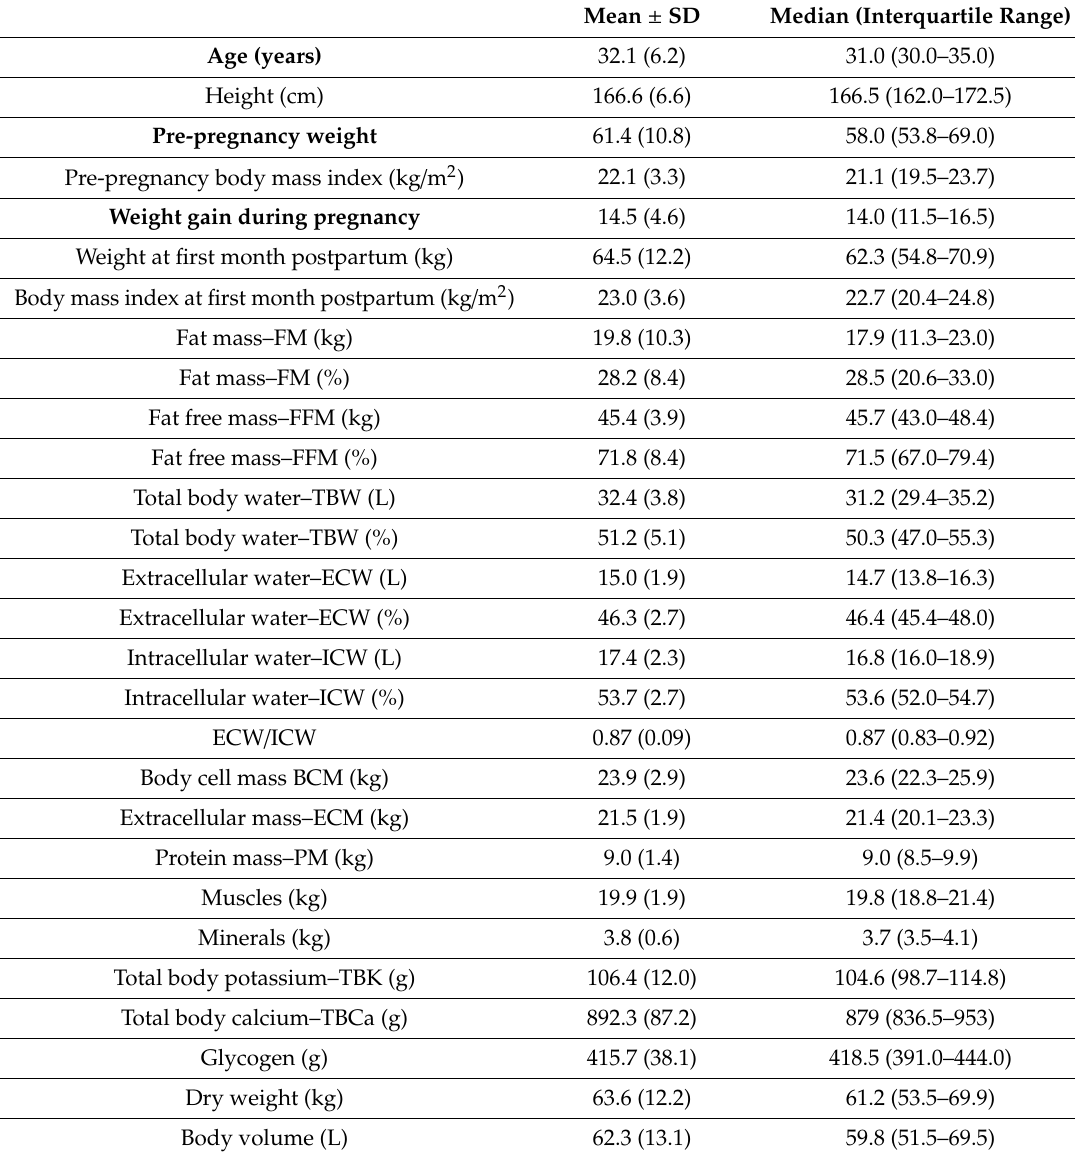
Table 2. Subjects’ anthropometric data and body composition